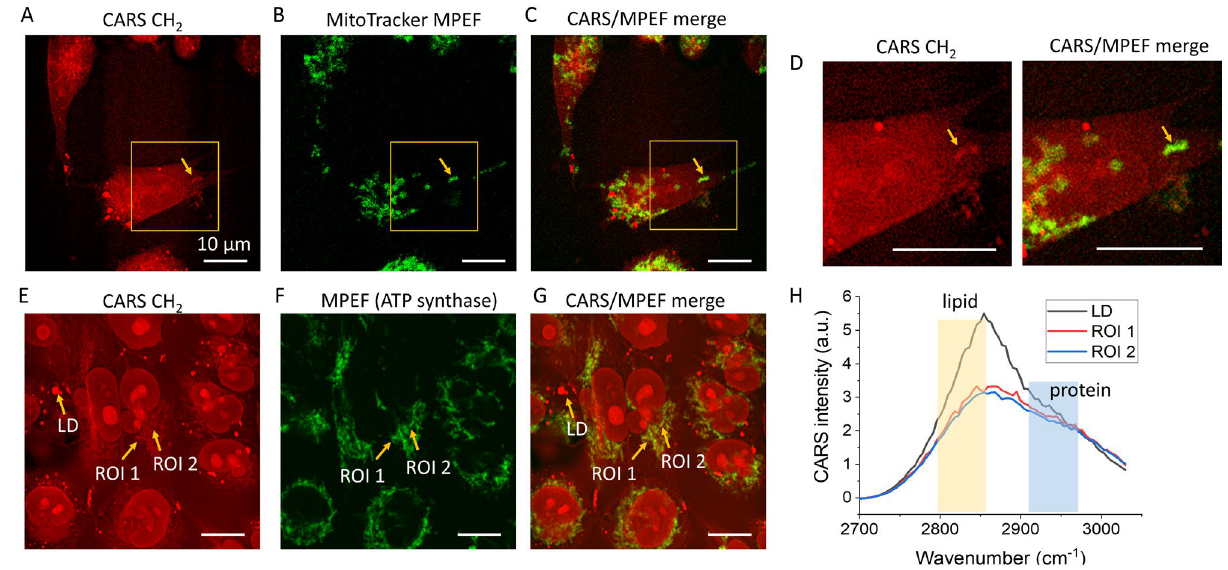
Figure 2. Verifying mitochondrial structures using fluorescent labeling. ( A – C ) CARS, MPEF, and CARS/ MPEF composite images of MitoTracker labeled live MIAPaCa-2 cells, respectively. Arrows point out the target of interest. ( D ) Magnified images of areas indicated by the yellow boxes in panels ( A , C ). ( E – G ) CARS, MPEF, and CARS/MPEF composite images of immunofluorescence labeled (anti-ATPB) MIAPaCa-2 cells, respectively. Different arrows point to different targets and regions of interest (ROIs) in these images. ( H ) The original CARS spectra obtained from hyperspectral imaging. Scale bars represent 10 µm and apply to all images. Panel ( H ) is generated by Origin